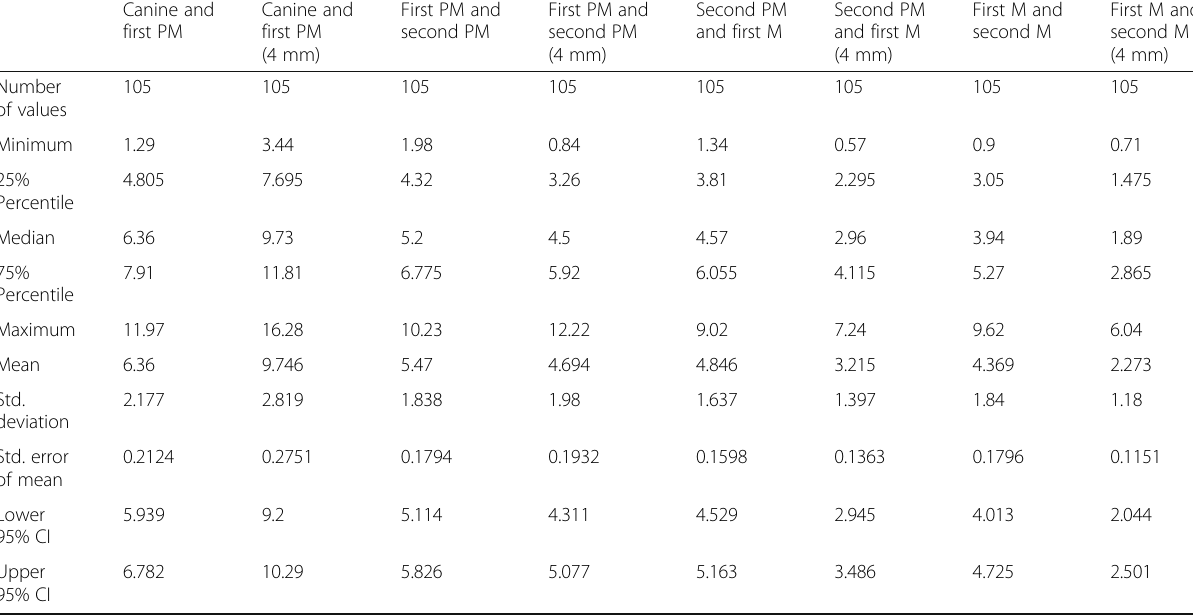
Table 2 Palatal bone thickness in growing female Canine and Canine and first PM first